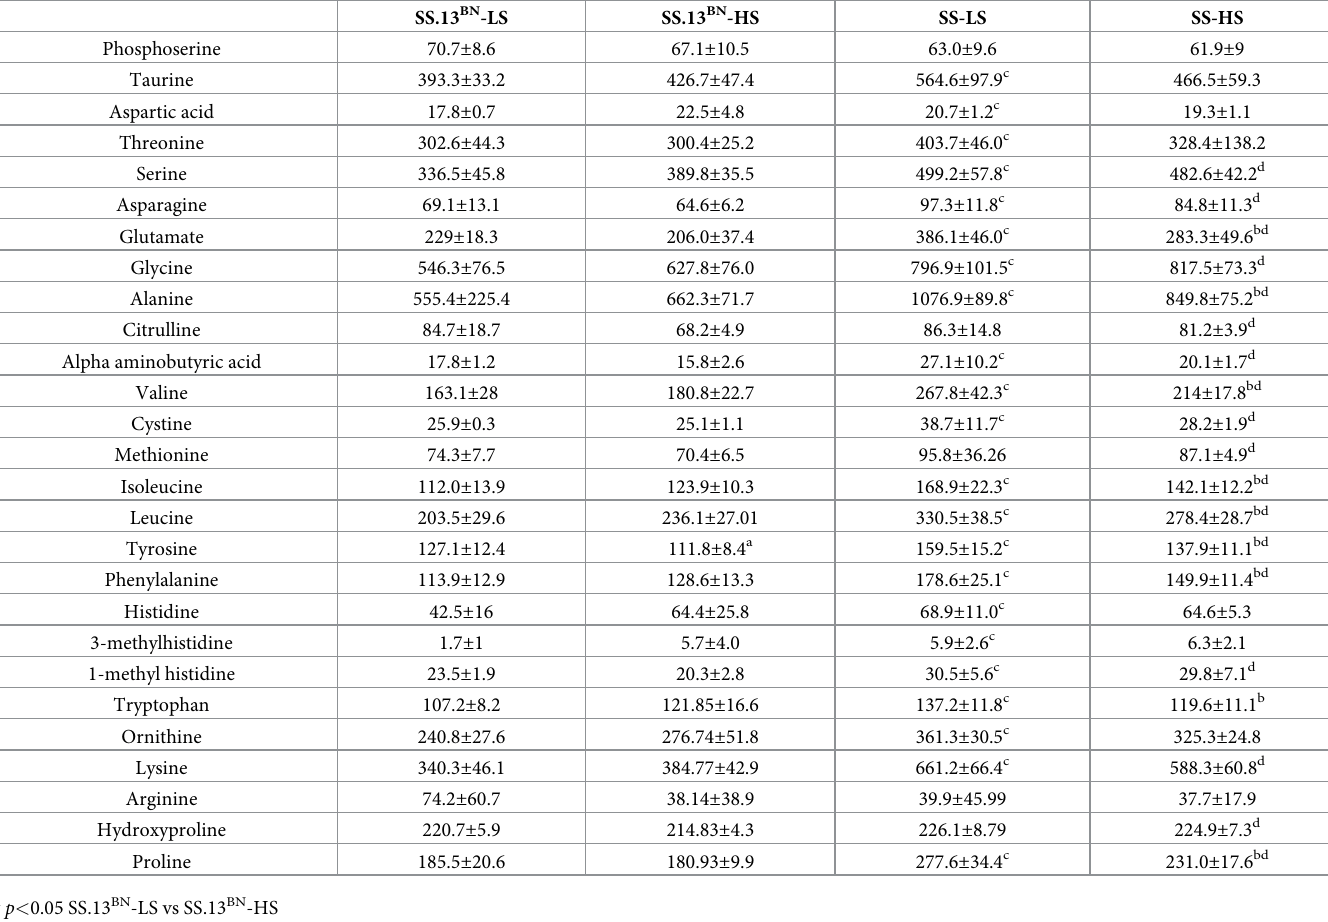
Table 1. Data for amino acids in the serum of Dahl SS rats and SS.13 BN rats fed a low salt or high salt diet ( μ